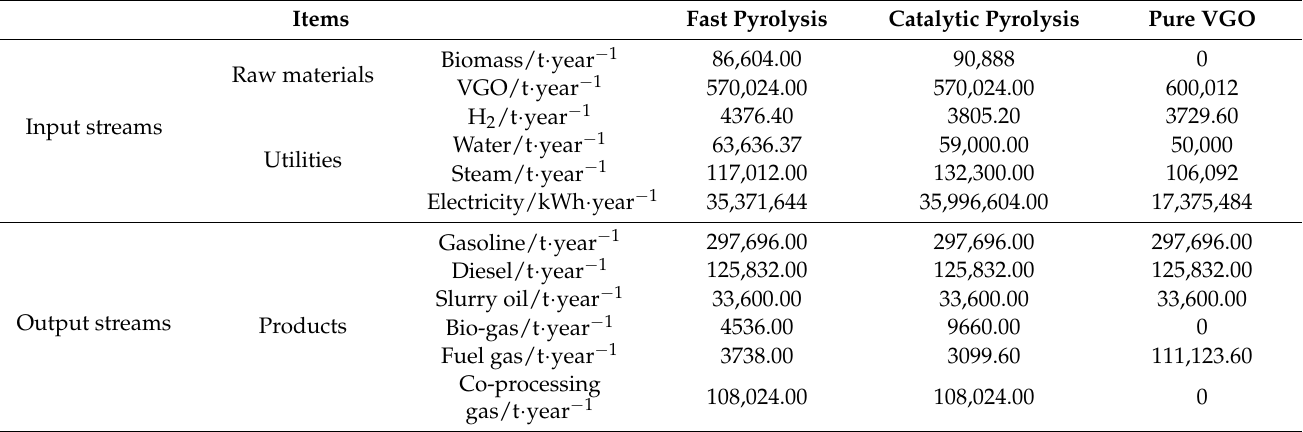
Table 9. Total consumptions of raw materials and utilities as well as the products in Case